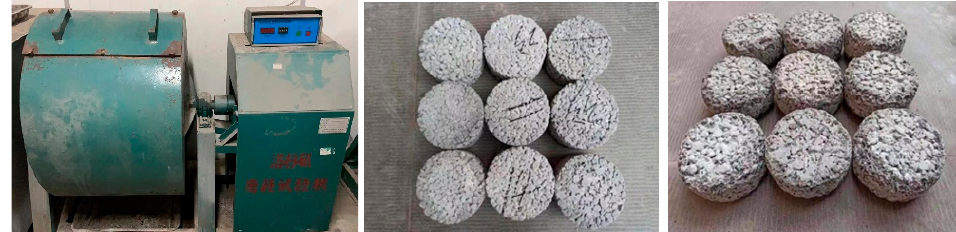
Figure 4. Los Angeles Abrasion Tester and the morphology of porous concrete before and after scatter.